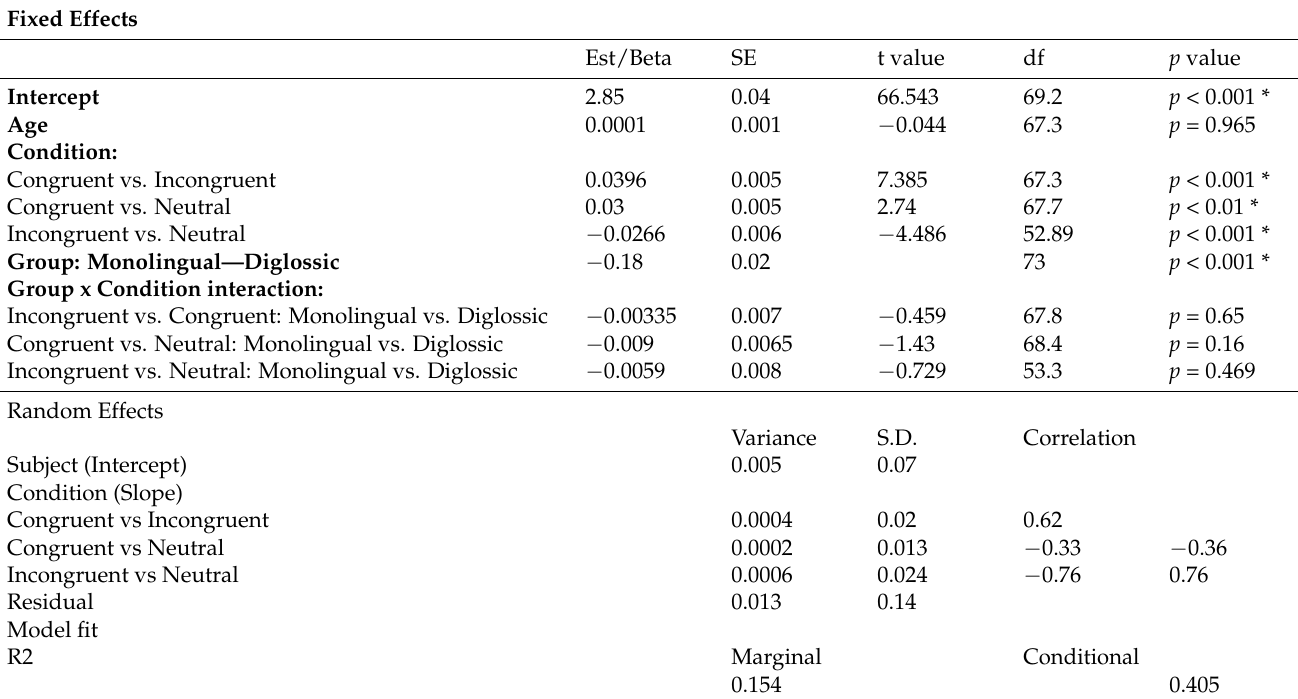
Table 4. Reaction time results for the Stroop